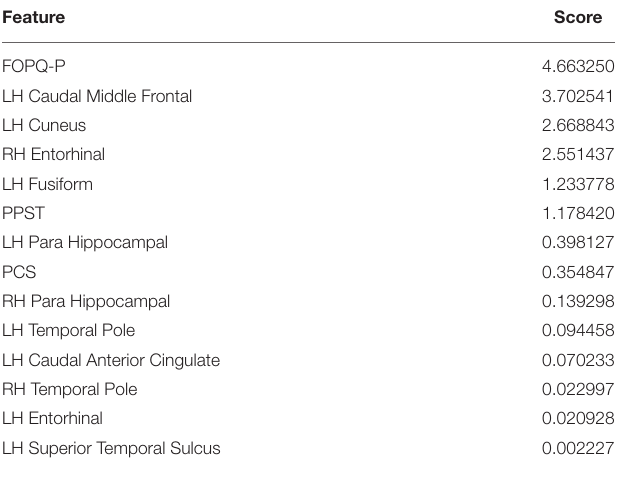
TABLE 2 | Importance or Contribution scores of the 14 reduced selected features by the SelectKBest feature selection method.